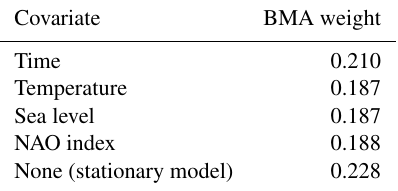
Table 1. Total BMA weight associated with each candidate covari- ate’s nonstationary models and a stationary model (ST) for the full set of 13 candidate models, all considered simultaneously in the BMA weighting.